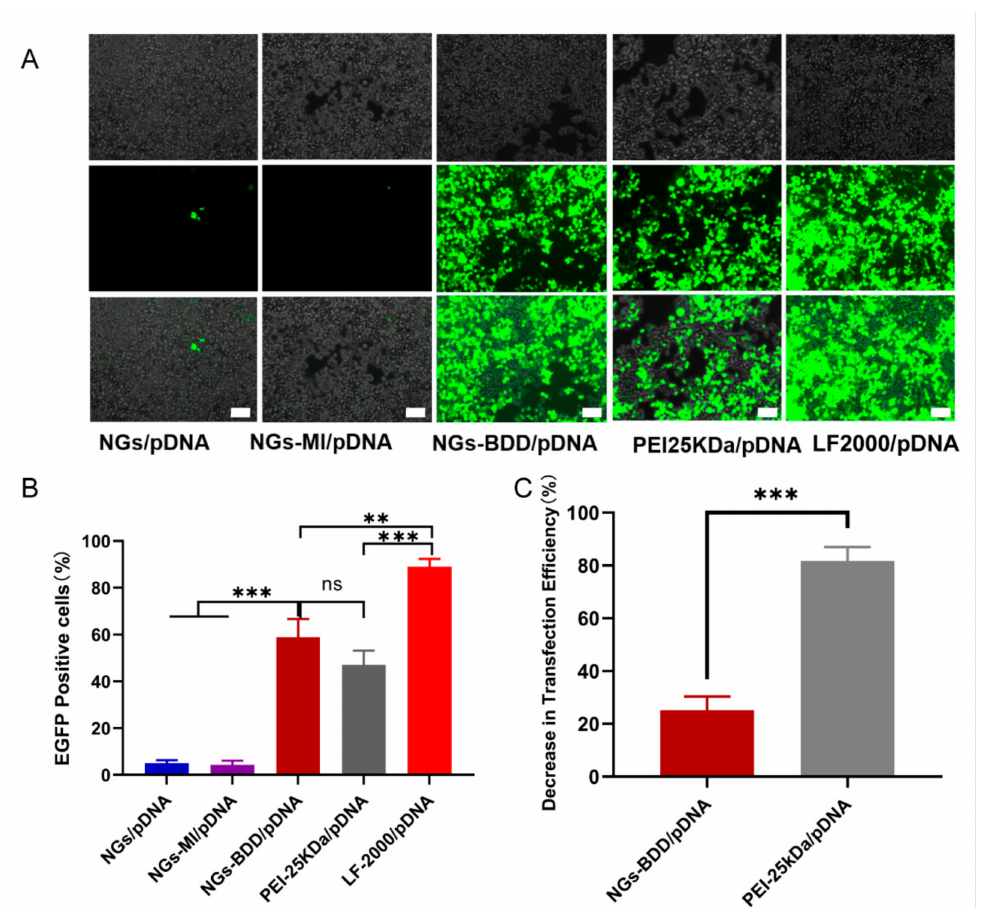
Figure 6. Transfection efficiency with nanogel/pDNA PEI/pDNA and LF2000/pDNA complexes in HEK293T cells. ( A ) Light microscopy images of nanogel-treated HEK293T cells (upper row: phase contrast; middle row: fluorescence; lower row: merged phase contrast and fluorescence. Scale bars indicate 100 µ m). ( B ) Percentage of EGFP-positive cells measured by flow cytometry after treatment with complexes for 48 h. ( C ) Decrease in percentage of EGFP-positive cells after treatment with NG-BDD/pDNA complexes and PEI-25kDa/pDNA complexes in the presence of Bafilomycin A1 compared to treatment in the absence of Bafilomycin A1. Data present mean ± SD of three independent experiments performed in duplicate (** p < 0.005, *** p <